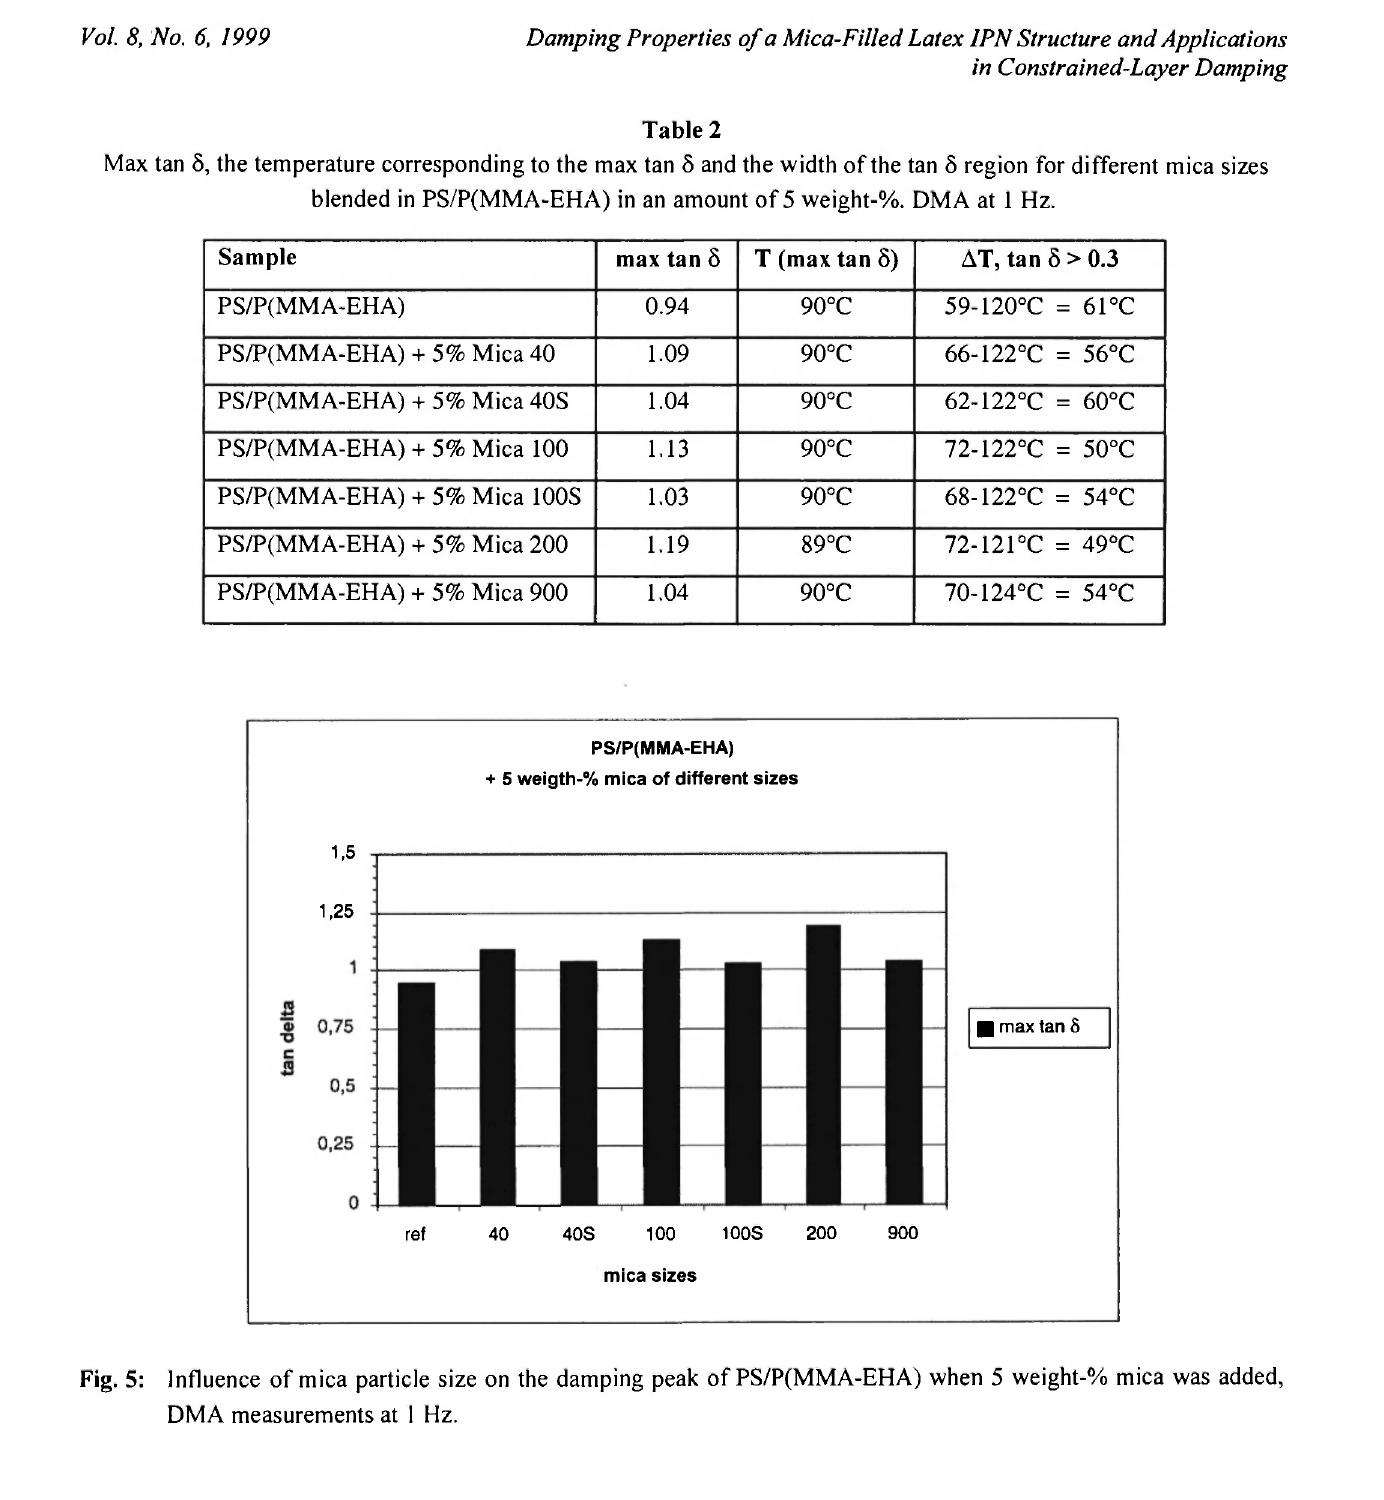
Max tan δ, the temperature corresponding to the max tan δ and the width of the tan δ region for different mica sizes blended in PS/P(MMA-EHA) in an amount of 5 weight-%. DMA at 1 Hz.